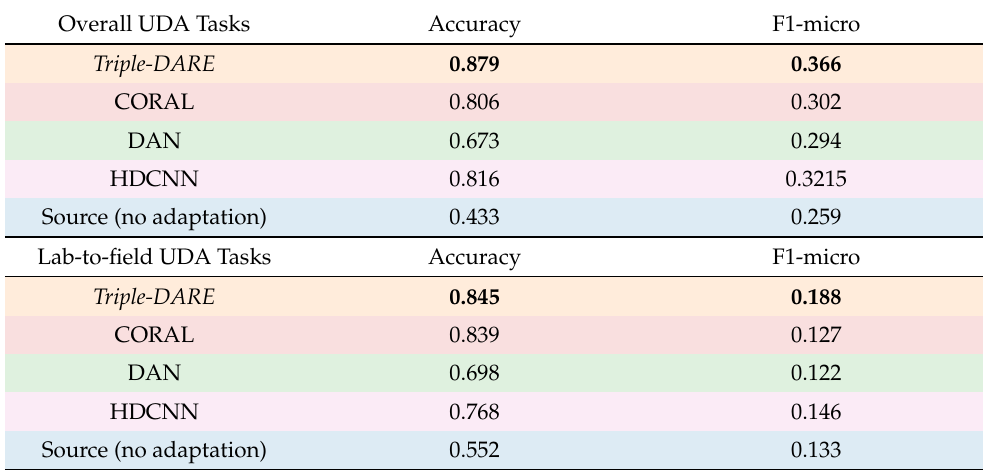
Table 6. Overall context prediction scores on the target domain.